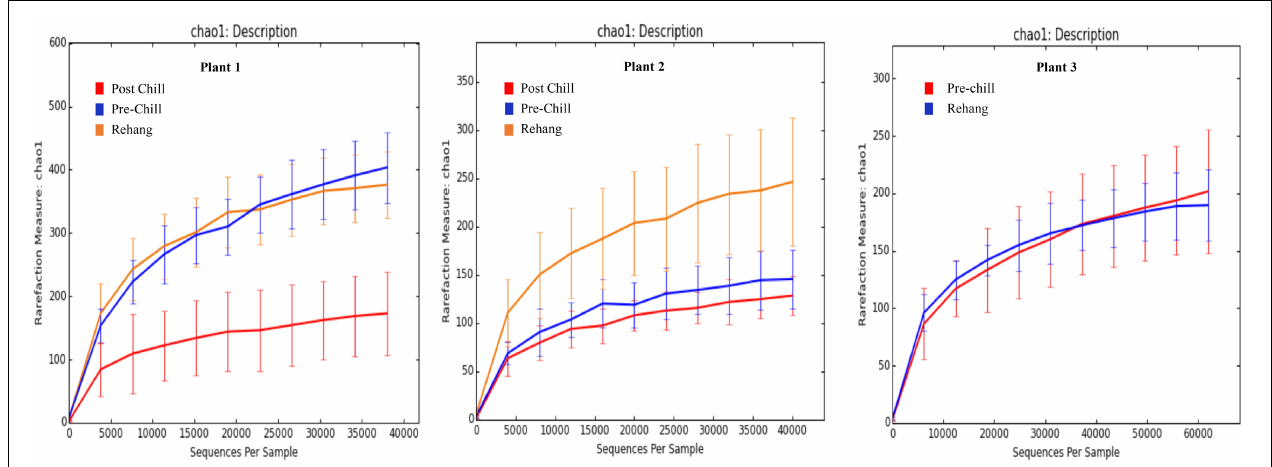
FIGURE 5 | Chao 1 rarefaction curve. The measure of richness within a community at each processing abattoir and testing location within the plant.